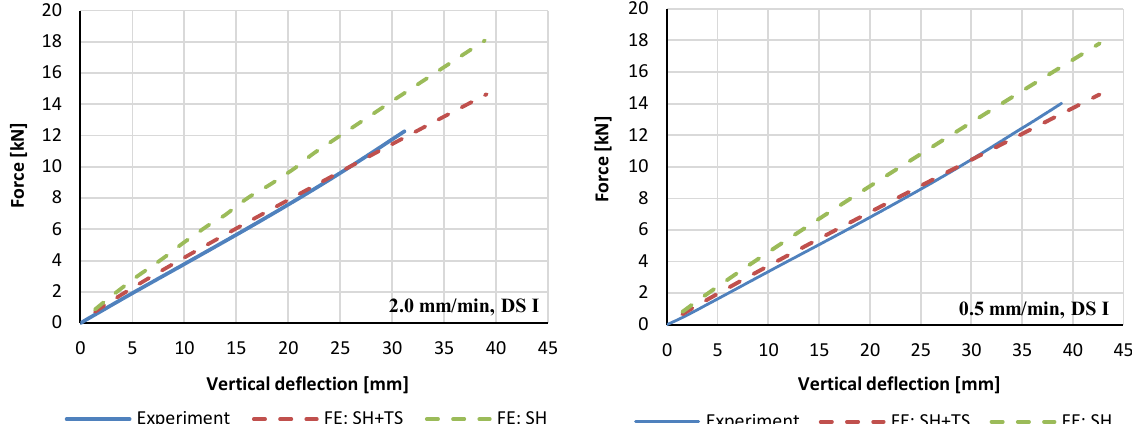
Fig. 13 Comparison of experimental and numerical midspan displacements by DS I of representative panel in displacement controlled